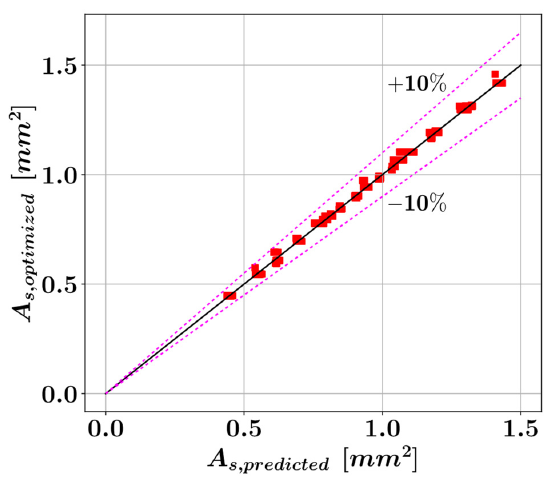
Figure 12. Comparison of the predicted and actual optimal reinforcement areas .